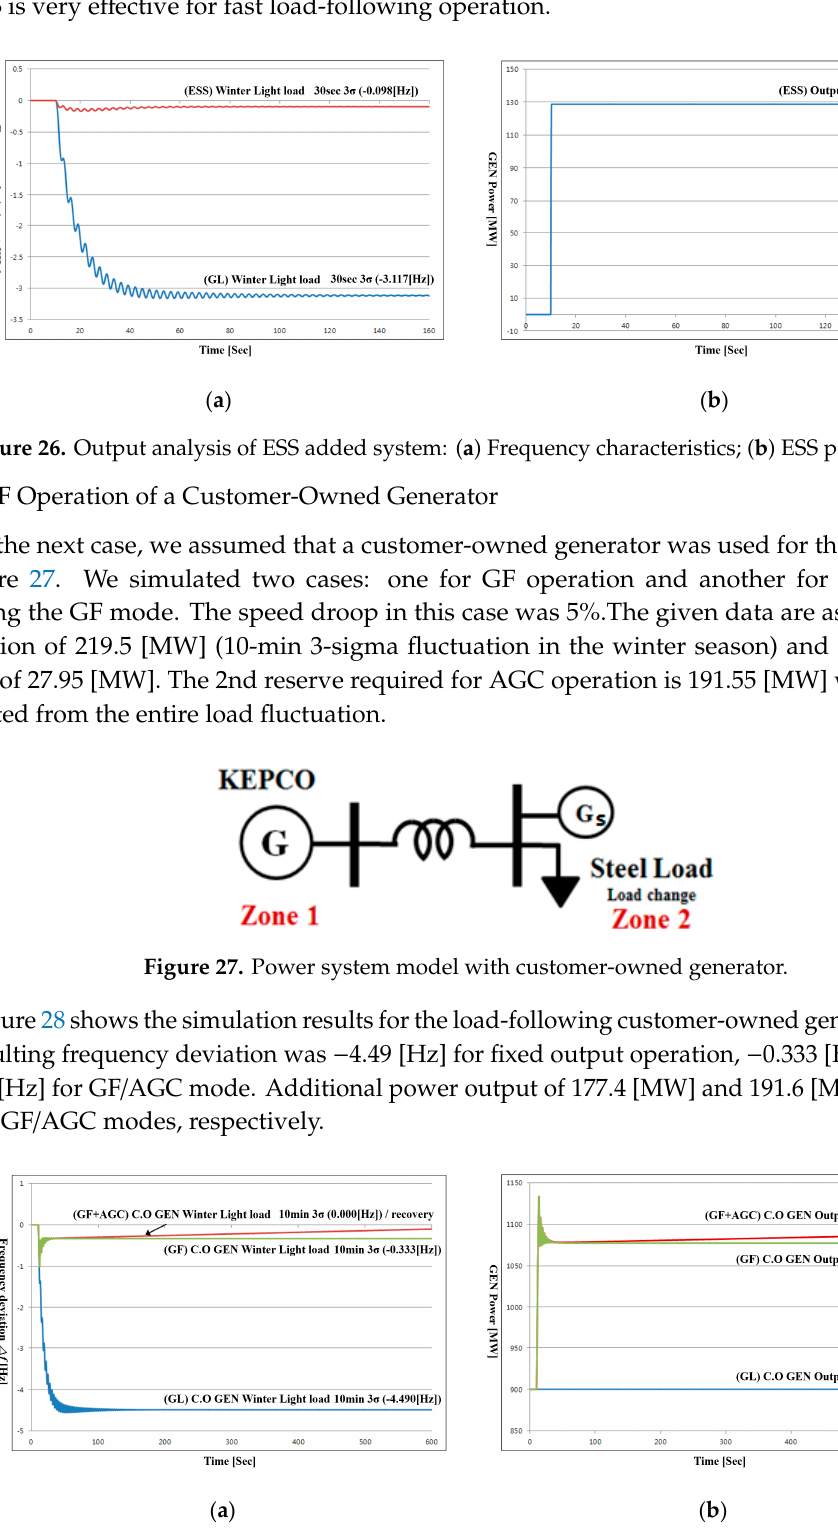
Figure 28. Output analysis when a customer-owned (CO) generator is used for frequency regulation: ( a ) Frequency characteristics; ( b ) Generator power output.